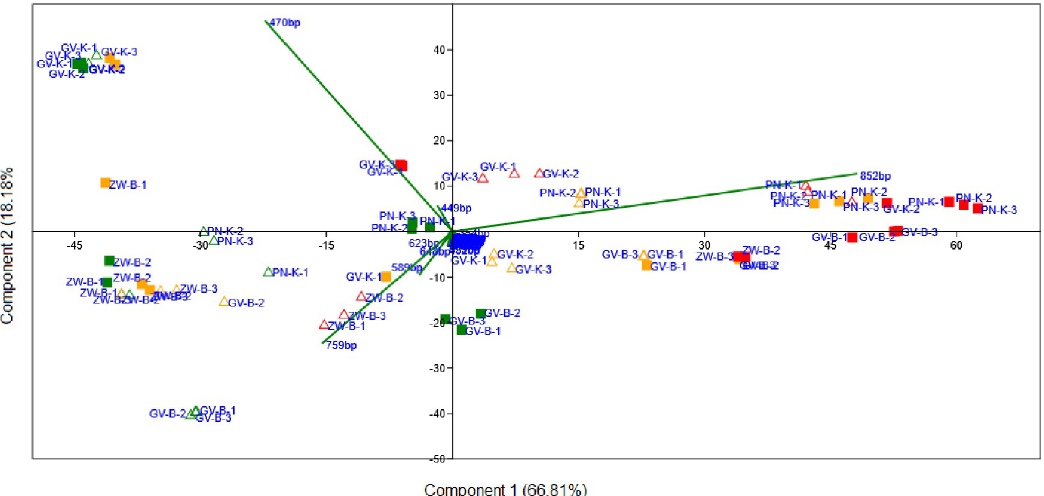
Fig 1. PCA biplot comparing the population dynamics. The start (green), middle (orange) and end of fermentation (red), inoculated (filled square) spontaneous (triangle) variants, Zweigelt from Burgenland (ZW-B), Gru¨ner Veltliner from Burgenland and Klosterneuburg (GV-B and GV-K), Pinot not from Klosterneuburg (PN-K). Three replicates were analysed for each fermentation and represented numerically (1,2,3).